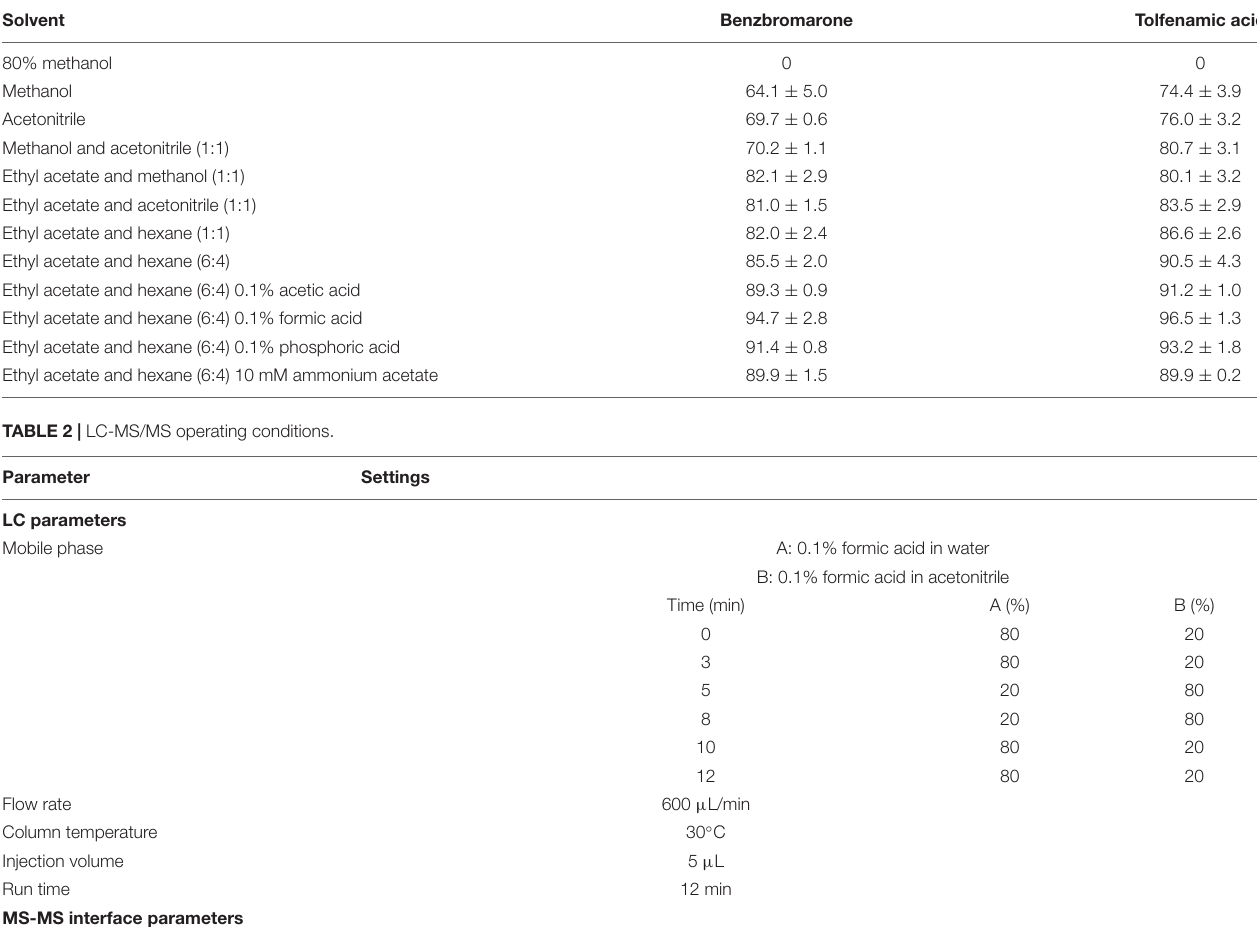
TABLE 1 | Optimization of the extraction efficiency for benzbromarone and tolfenamic acid in citrus matrices.